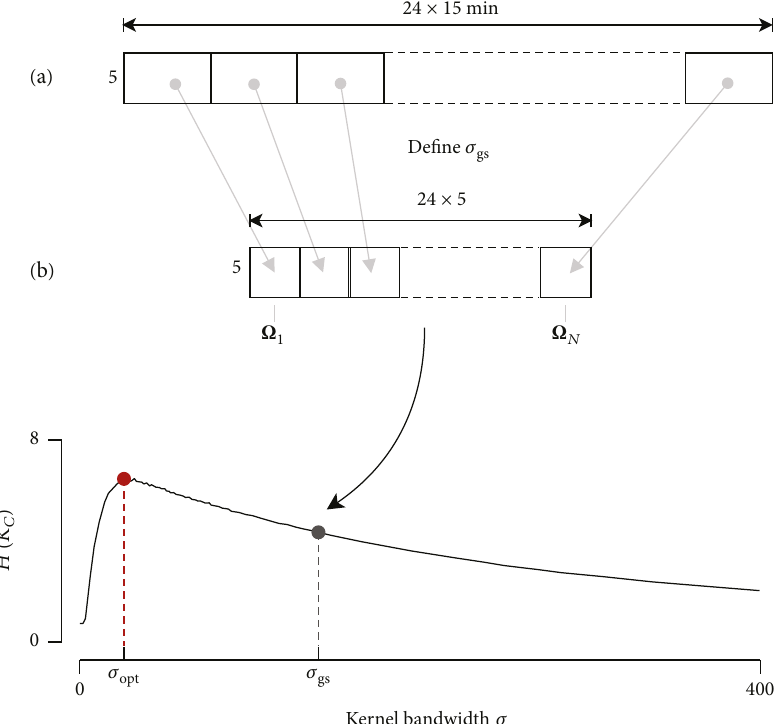
Figure 4: Method used to tune the kernel bandwidth σ . In (a), the data is segmented in nonoverlapping signal segments of 15 minutes. For all of these segments, a kernel matrix Ω which is depicted in (b). Next, the Shannon entropy of Ω associated with maximal H Ω C is selected as the bandwidth for the kernel